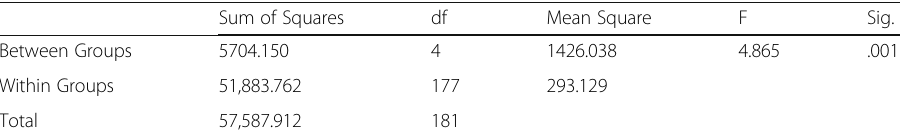
Table 2 ANOVA of Foreign Language Anxiety Scale Sum of Squares df Mean Square F Sig. Between Groups .001 Within